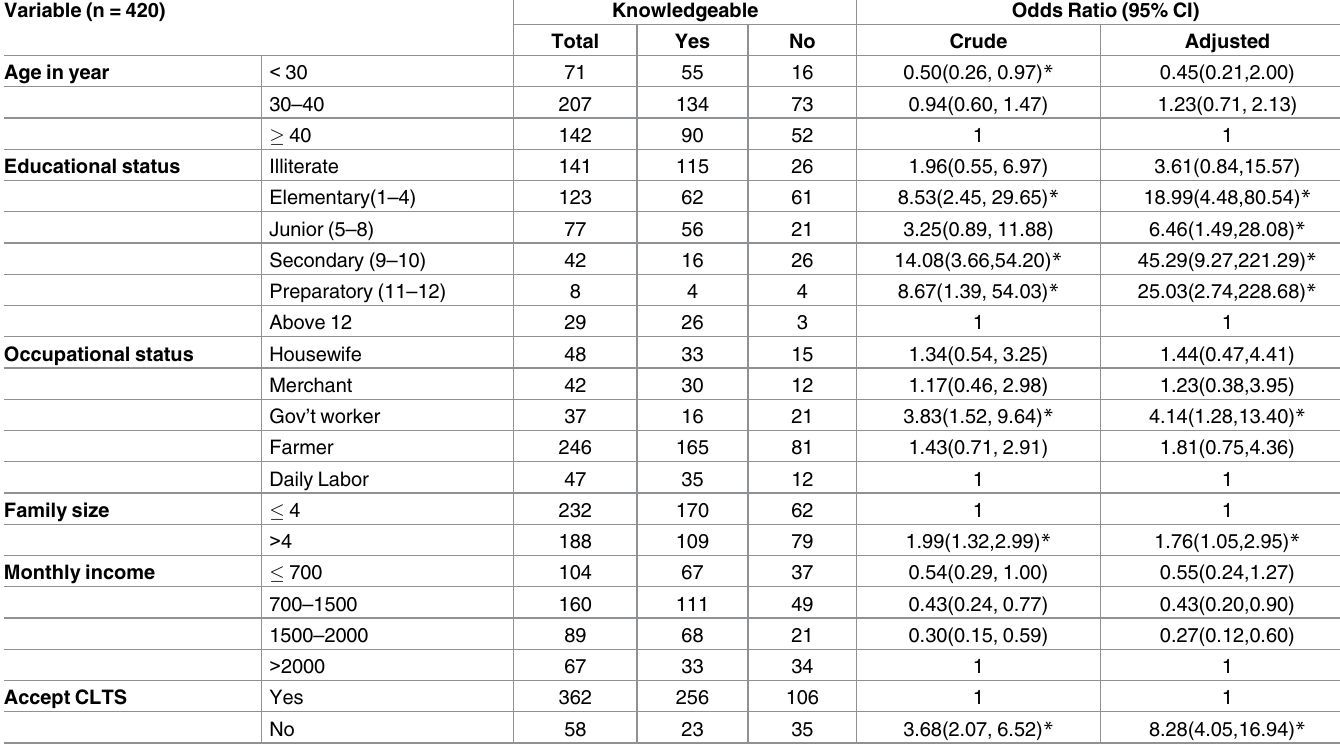
Table 2. Selected variables measuredby knowledge of CLTSH among study participants in Diretiyaradistrict, Ethiopia, 2014. Variable (n =